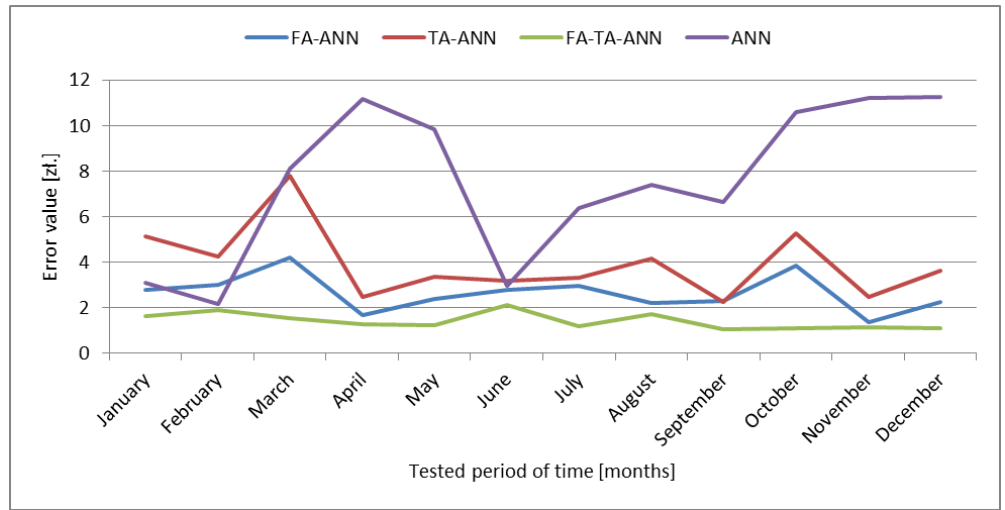
Figure 8. Comparison of E max values per month using all ANN-based models over one year (2010) for BUDIMEX SA. Table 2. Arithmetical means of monthly E max values (absolute and relative) for one year (2010).